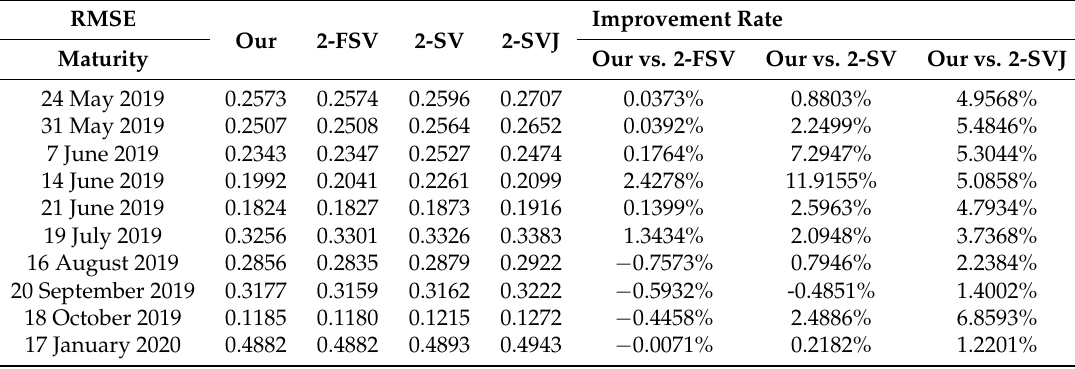
Table 2. Out-of-sample pricing errors. Note: This table shows the out-of-sample pricing errors across different maturities. Pricing errors are reported as the root mean squared errors (RMSE) of option prices for four